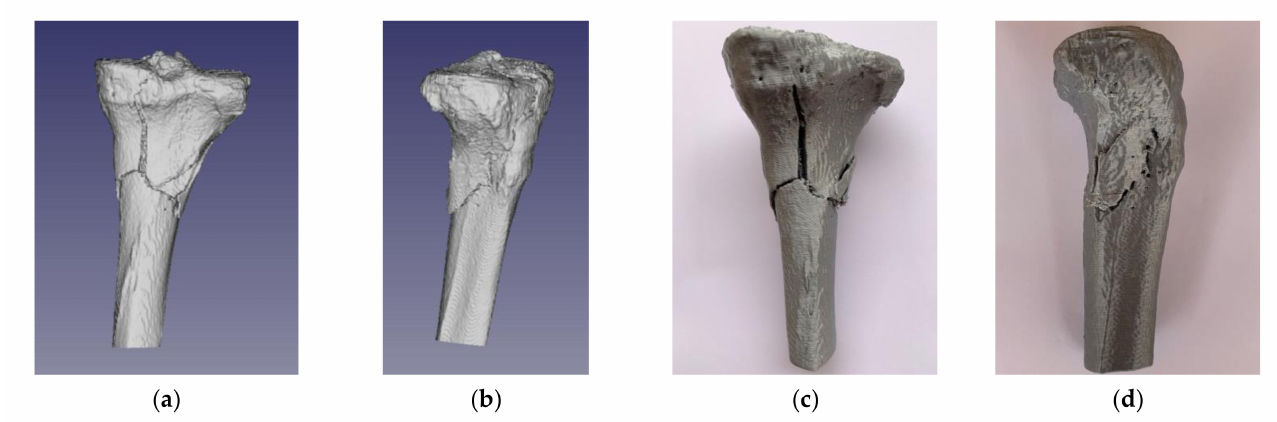
Figure 9. Tibial plateau fracture Schatzker type VI: ( a ) posterior view of the 3D segmented model; ( b ) lateral view of the 3D segmented model; ( c ) posterior view of the 3D printed replica; ( d ) lateral view of the 3D printed